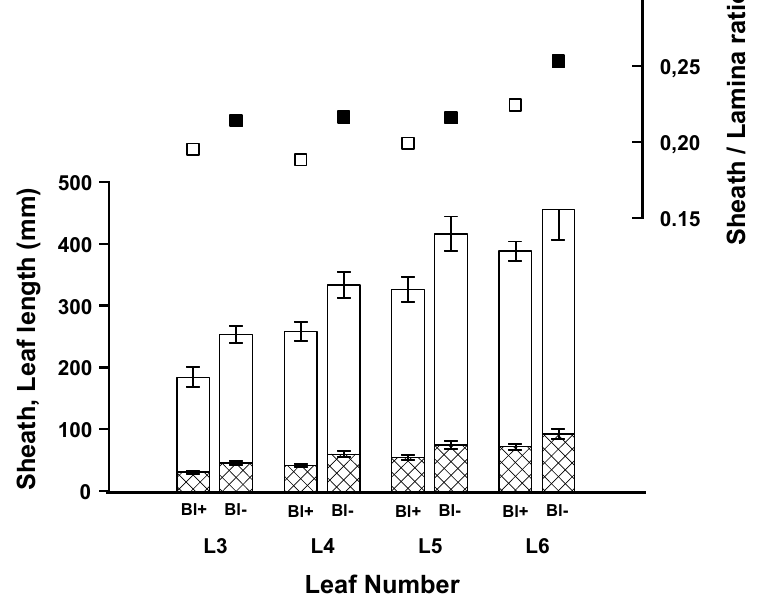
Figure 4. Effects of blue light on the final length of the sheath (hatched bar) and lamina (unfilled bar) of the four successive leaves of the main tiller of ryegrass ( Lolium perenne ). Light is provided by metallic iodure lamps (Blue+, □ ) or by sodium pressure lamps plus filters removing blue wavelengths (400–550 nm) and compensated to maintain a similar PAR (Blue − , ■ ). Adapted from